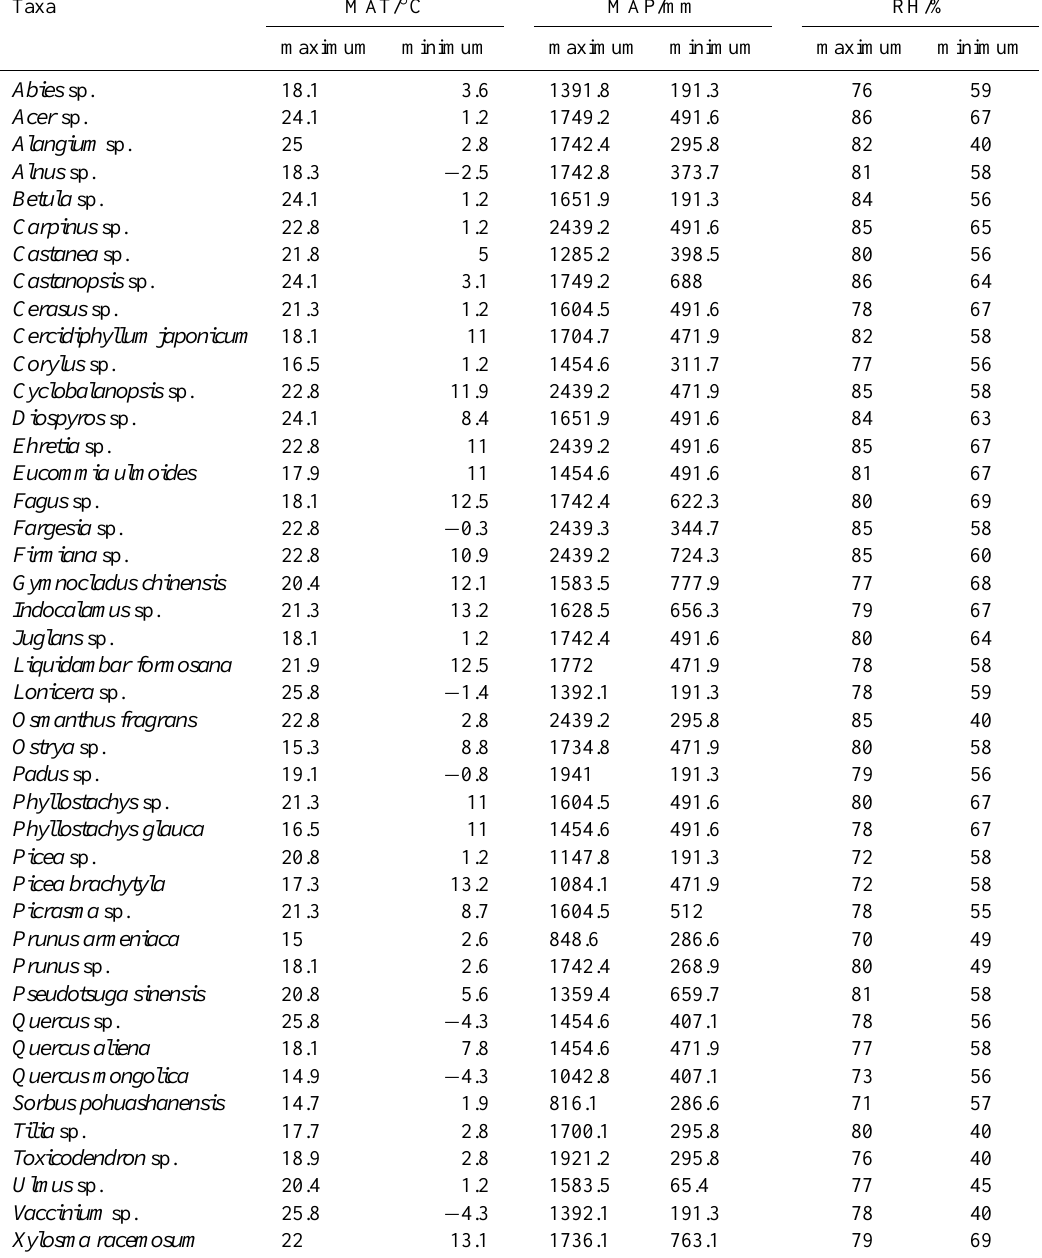
Table 4. The climatic range of the single plant taxa. Taxa MAT/ ◦ C MAP/mm RH/% maximum minimum maximum minimum maximum minimum Abies sp. Acer sp. Alangium sp. Alnus sp. Betula sp. Carpinus sp.